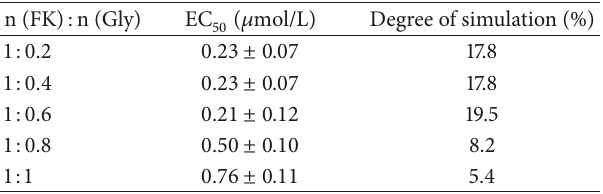
Figure 8: The comparison of O 2∙− scavenging activity of FK-Gly at different amounts of